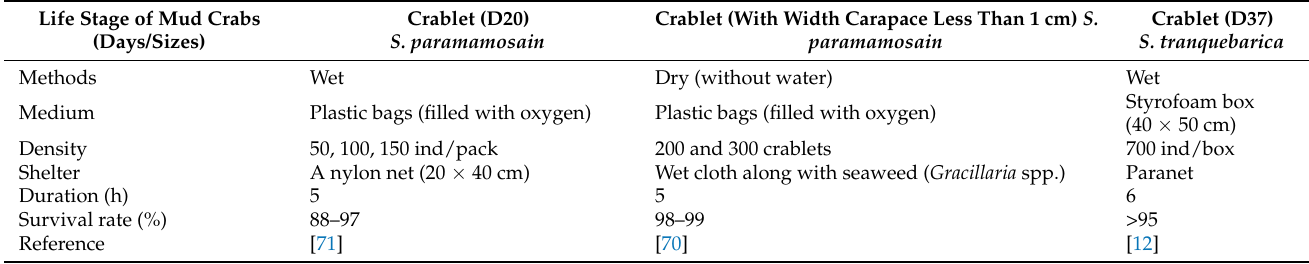
Table 4. Literature related to the transportation of mud crab